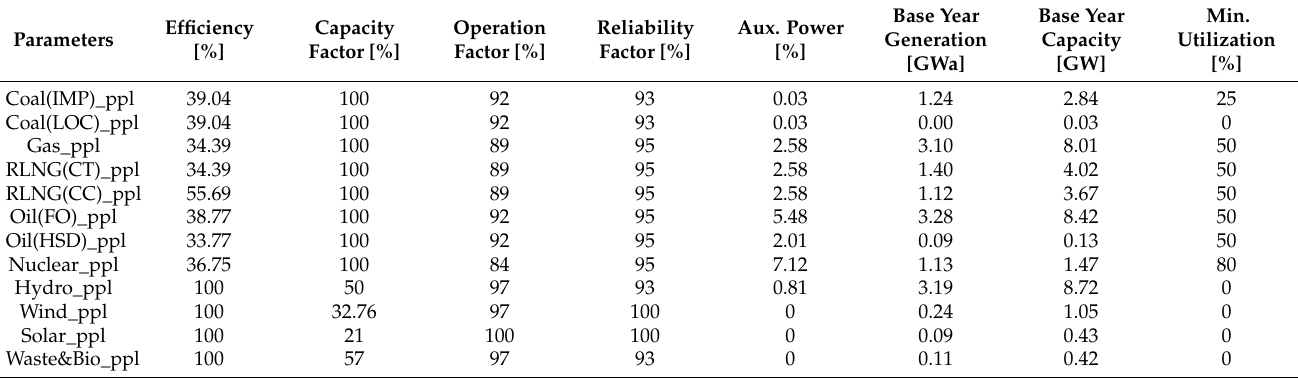
Table 12. Technical details and base year status of technologies [9,32].